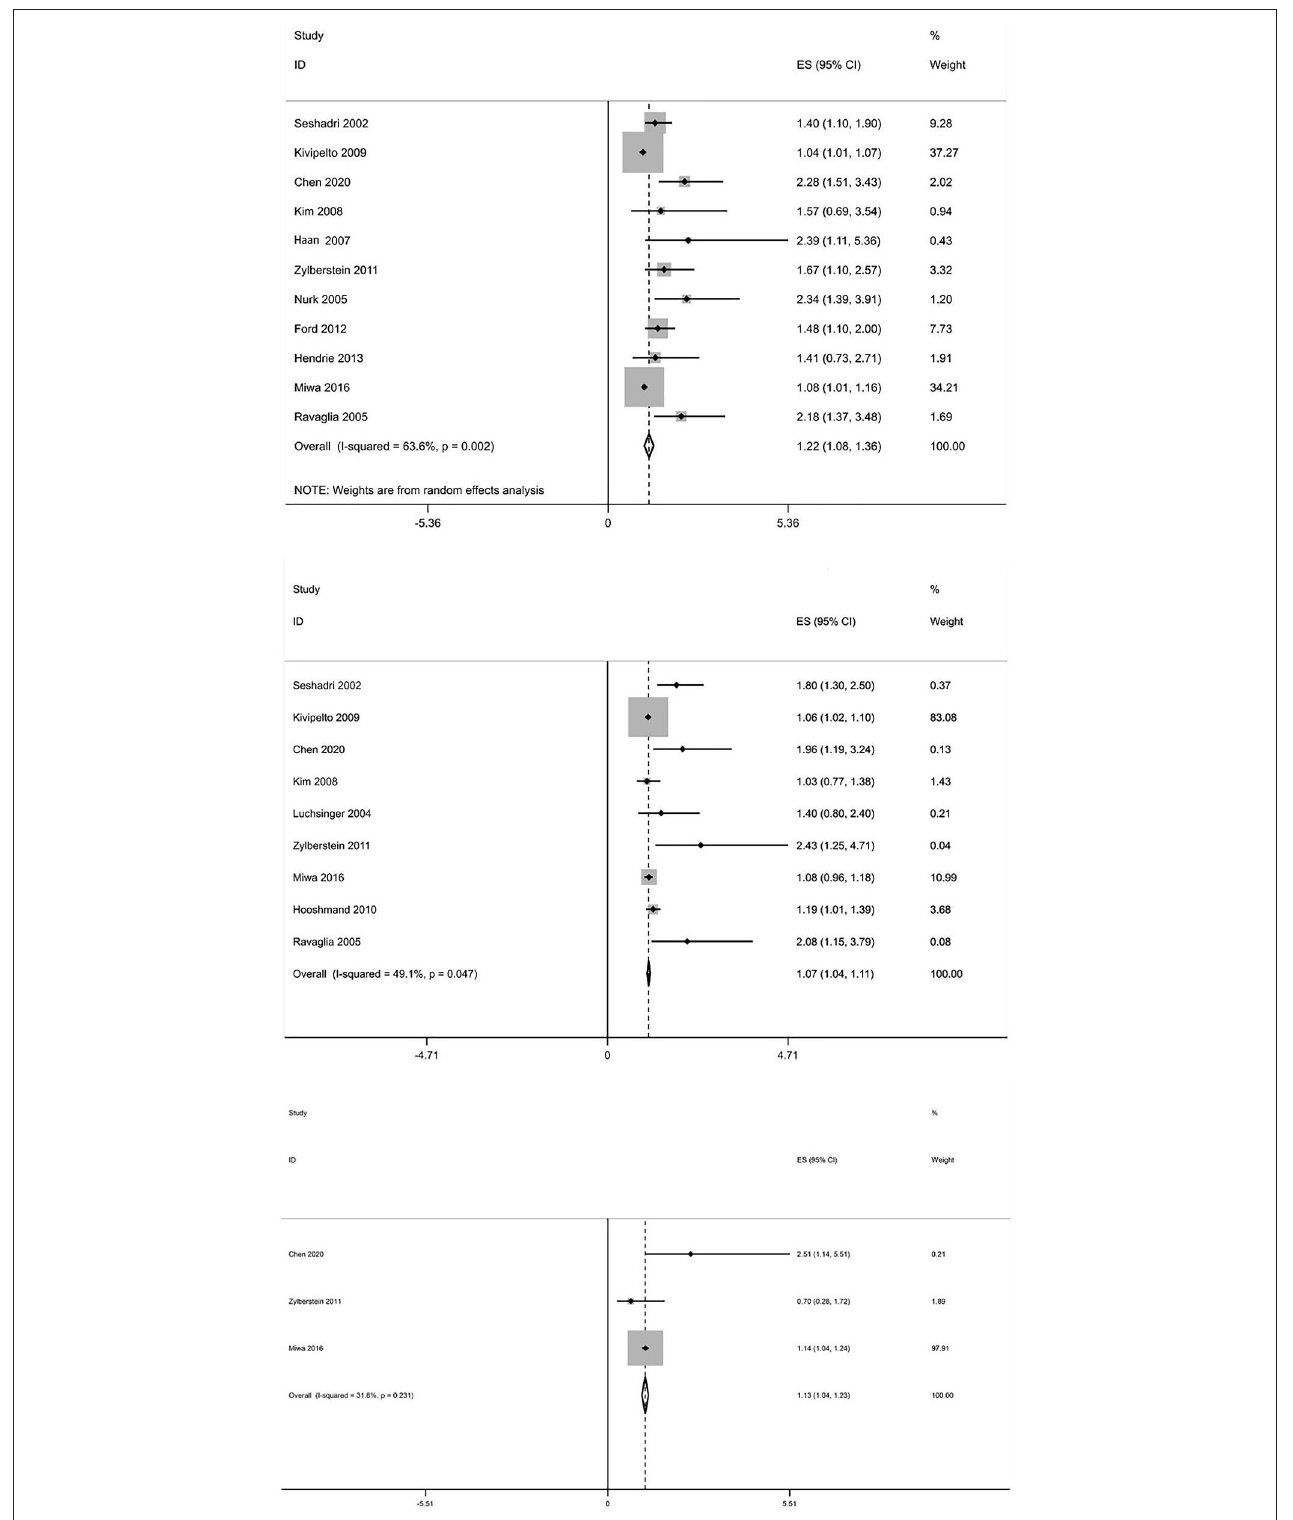
FIGURE 5 | Forest plot of relative risk (RR) and 95% confidence interval (95%CI) in dementia (all-caused dementia, AD, and VaD) and control group for homocysteine.